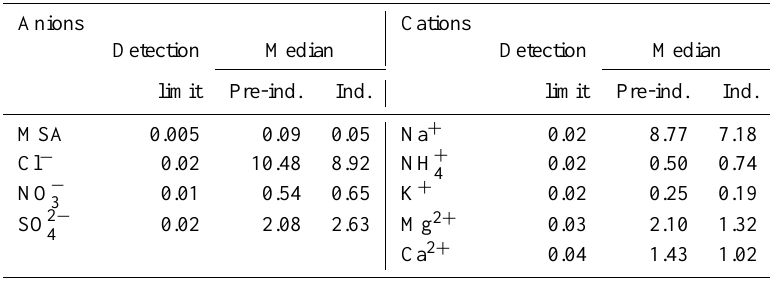
Table 1. Detection limits and median values ( µ eqL − 1 ) for the ions analysed with the Metrohm 850 Professional IC. Pre-ind.: pre-industrial time from 1222 to 1859; Ind.: industrial time from 1860 to 2009; MSA: CH 3 SO −